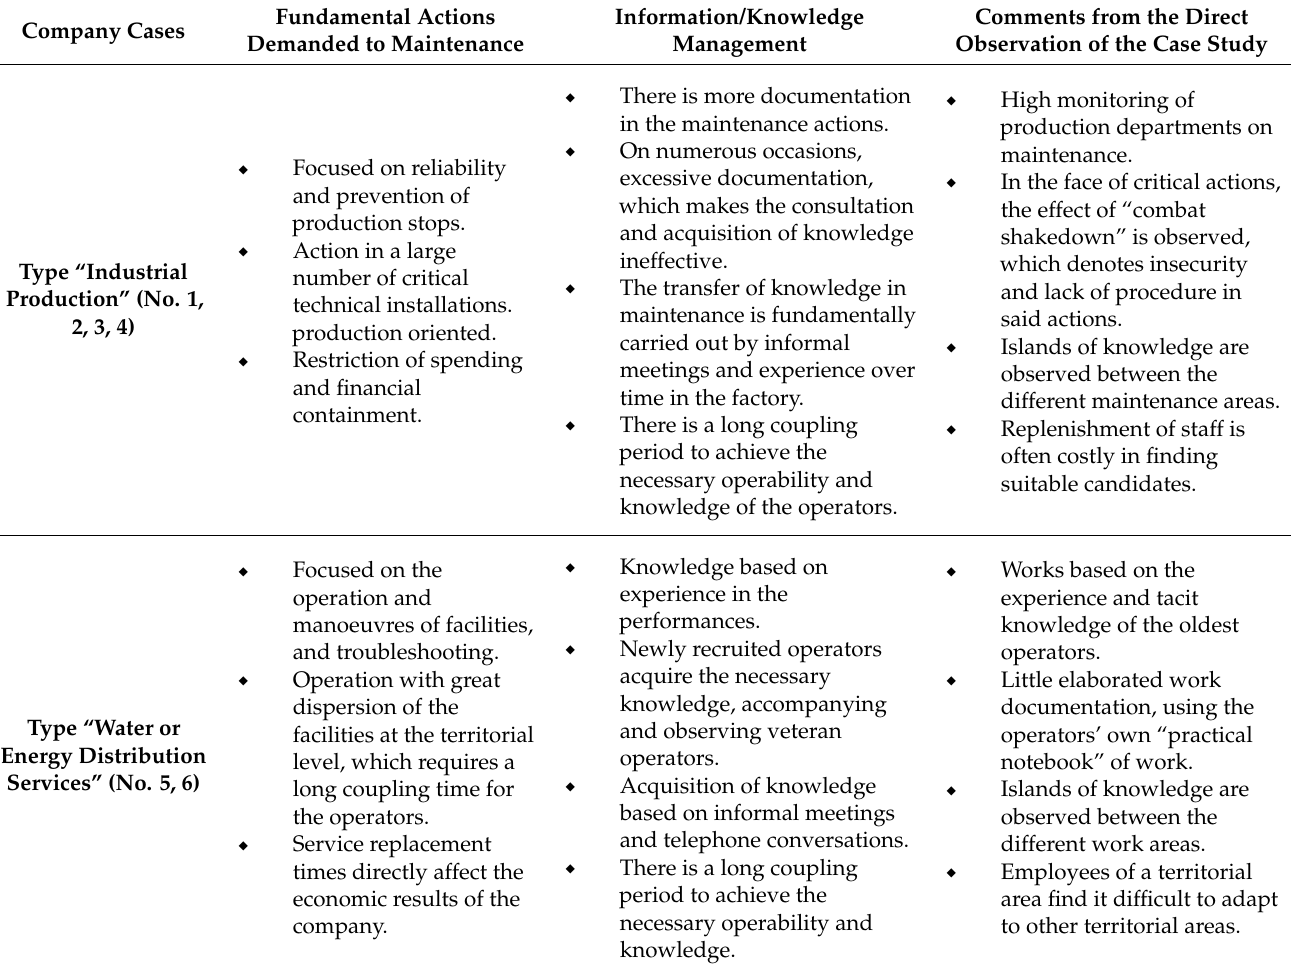
Table 2. Characteristics observed in the case study in reference to maintenance. Company Cases